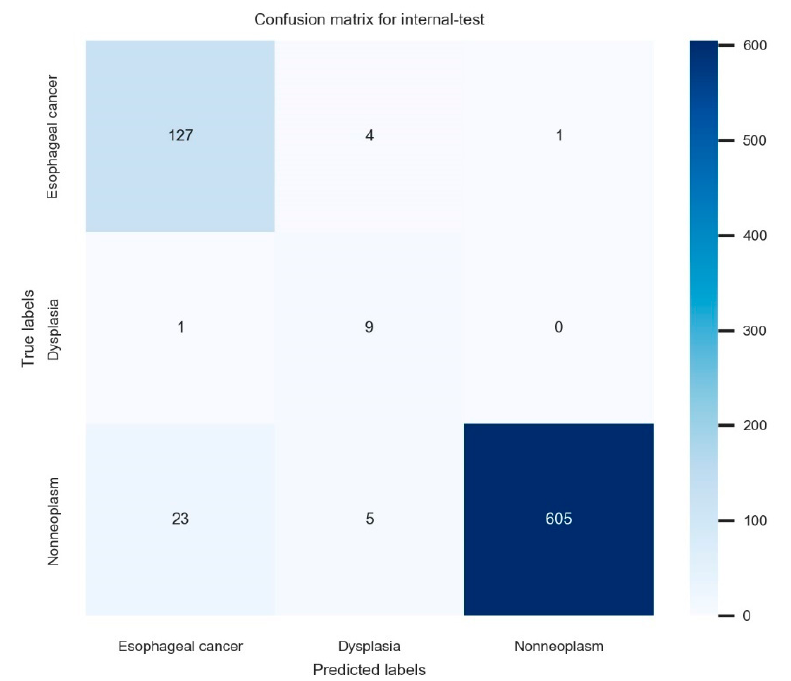
Figure 2. The confusion matrix for the established model in the internal test. Table 3. Summary of the internal- and external-test performance metrics for the established deep- learning model.